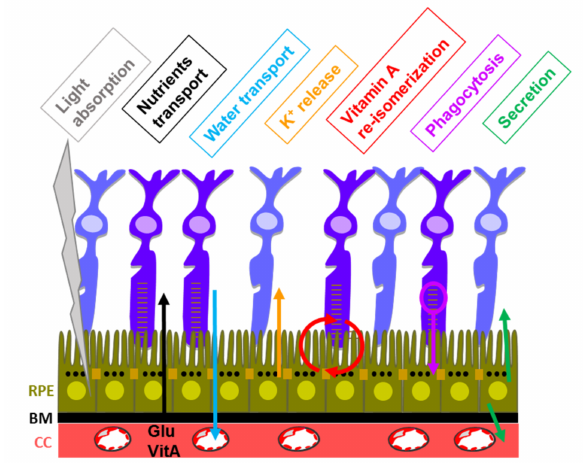
Figure 1. Functions fulfilled by the RPE in the process of vision. BM: basement membrane; CC: choriocapillaris; Glu: glucose; VitA: vitamin A; RPE: retinal pigmented epithelial cells. The arrows indicate nutrients transport (black arrow), water transport (blue arrow), K + release (orange arrow), vitamin A re-isomerization (red arrow), phagocytosis (purple arrow) and secretion (green